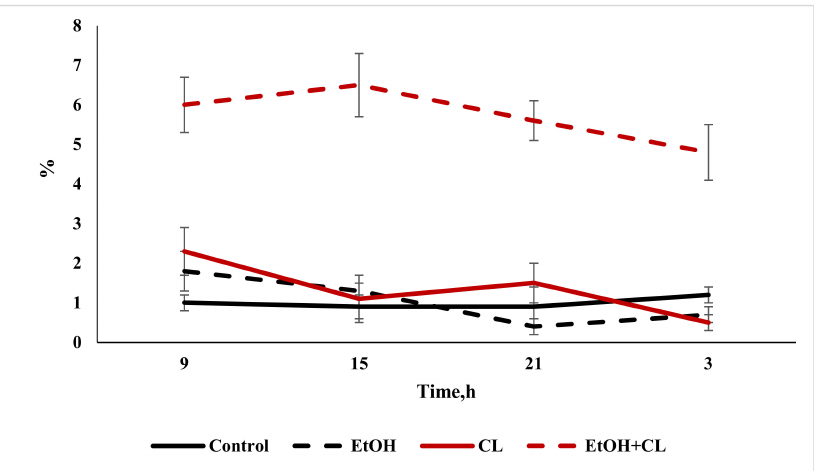
Figure 17. Daily fluctuations in the expression of Ki-67 in rat hepatocytes.